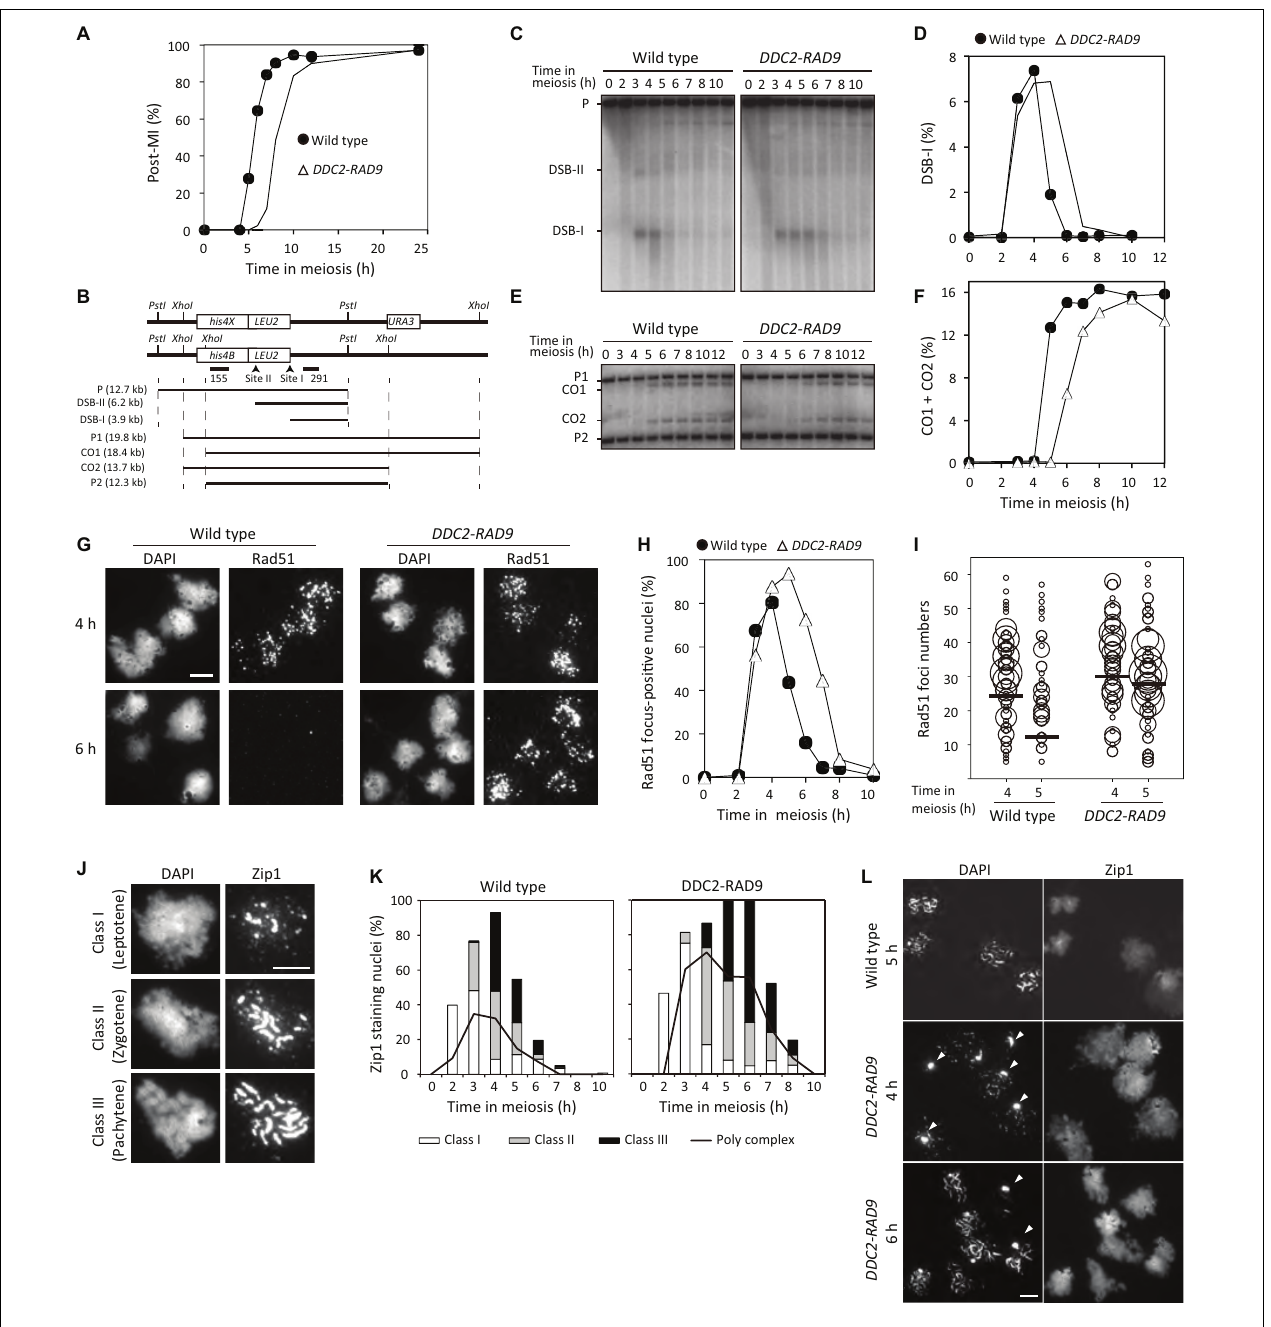
FIGURE 5 | DDC2-RAD9 impedes cell cycle progression and meiotic recombination. (A) Meiotic nuclear divisions were monitored in wild-type (USY543/544) and DDC2-RAD9 (USY544/671) strains by DAPI staining. The y -axis represents the percentage of cells that completed meiosis I and II (Post-MI). At least 200 cells were counted at each time point. (B) Schematic presentation of the HIS4-LEU2 DSB site. (C,E) Genomic DNAs were prepared from the indicated strains during the meiotic time course. Meiotic DSBs (DSB-I and DSB-II) (C) or crossover recombinants (CO1 and CO2) (E) were detected by Southern blot using the probes pNK291 or pNKY155 after genomic DSBs were digested with Pst I or Xho I, respectively. (D,F) Quantitative data of DSB-I (C) and CO1 + CO2 (E) obtained from Southern blot are plotted. (G–L) DDC2-RAD9 influences localization of Rad51 and Zip1 on meiotic chromosome. (G) The representative images of Rad51 immunostaining nuclear foci in spread nuclei prepared from the indicated strains at 4 and 6 h in meiosis are shown. (H) The percentage of the indicated cells’ nuclei that had more than 5 Rad51 foci was plotted at the indicated time points. (I) Distribution of nuclei according to Rad51 foci number per nucleus at the indicated time is presented using the same data samples as in (H) . Only nuclei that had more than 5 Rad51 foci were plotted. The size of the bubbles reflects the percentage of nuclei that had a certain foci number of Rad51 among all nuclei examined. Bars represent the average numbers of Rad51 foci. (J) Representative images of Zip1 staining classification are shown. (K) Classifications of Zip1 staining at the indicated time in the indicated strains are shown. The line represents the Zip1 polycomplex (PC). At least 100 nuclei were examined at each time point. (L) Representative images of Zip1 staining in DDC2-RAD9 at 4 h and 6 h are shown. Zip1 PCs are indicated by arrowheads. Experiments were performed at least twice, and representative data are shown. Bar equals 5 µ